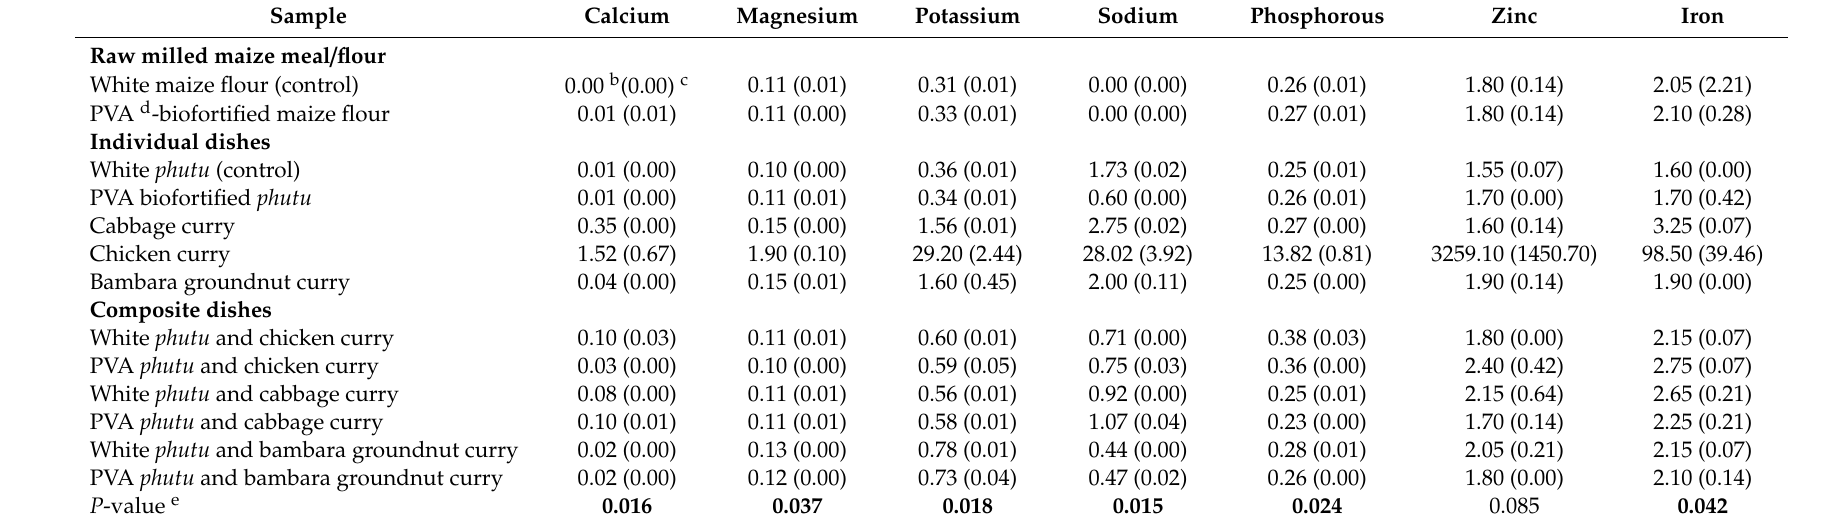
Table 7. Concentration of individual mineral elements of uncooked and cooked food samples except sweet potato (mg / 100 g, DW a ). Sample Calcium Magnesium Potassium Sodium Phosphorous Zinc Iron